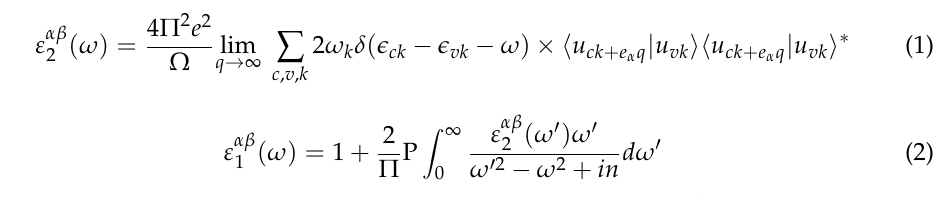
Figure 1. Model of studied metal oxide nanowire: low oxidized state CoO nanowire Pt(332) ( a ) and Pt(322) ( b ); and high oxidized state CoO 2 nanowire Pt(332) ( c ) and Pt(322) ( d ); Pt—grey spheres, Co—blue spheres, O—red spheres; ( e ) exchange channels between Co atoms: indirect exchange channel J 1 through oxygen atoms, direct exchange channels between Co atoms J 2 Co − Co Co − Co